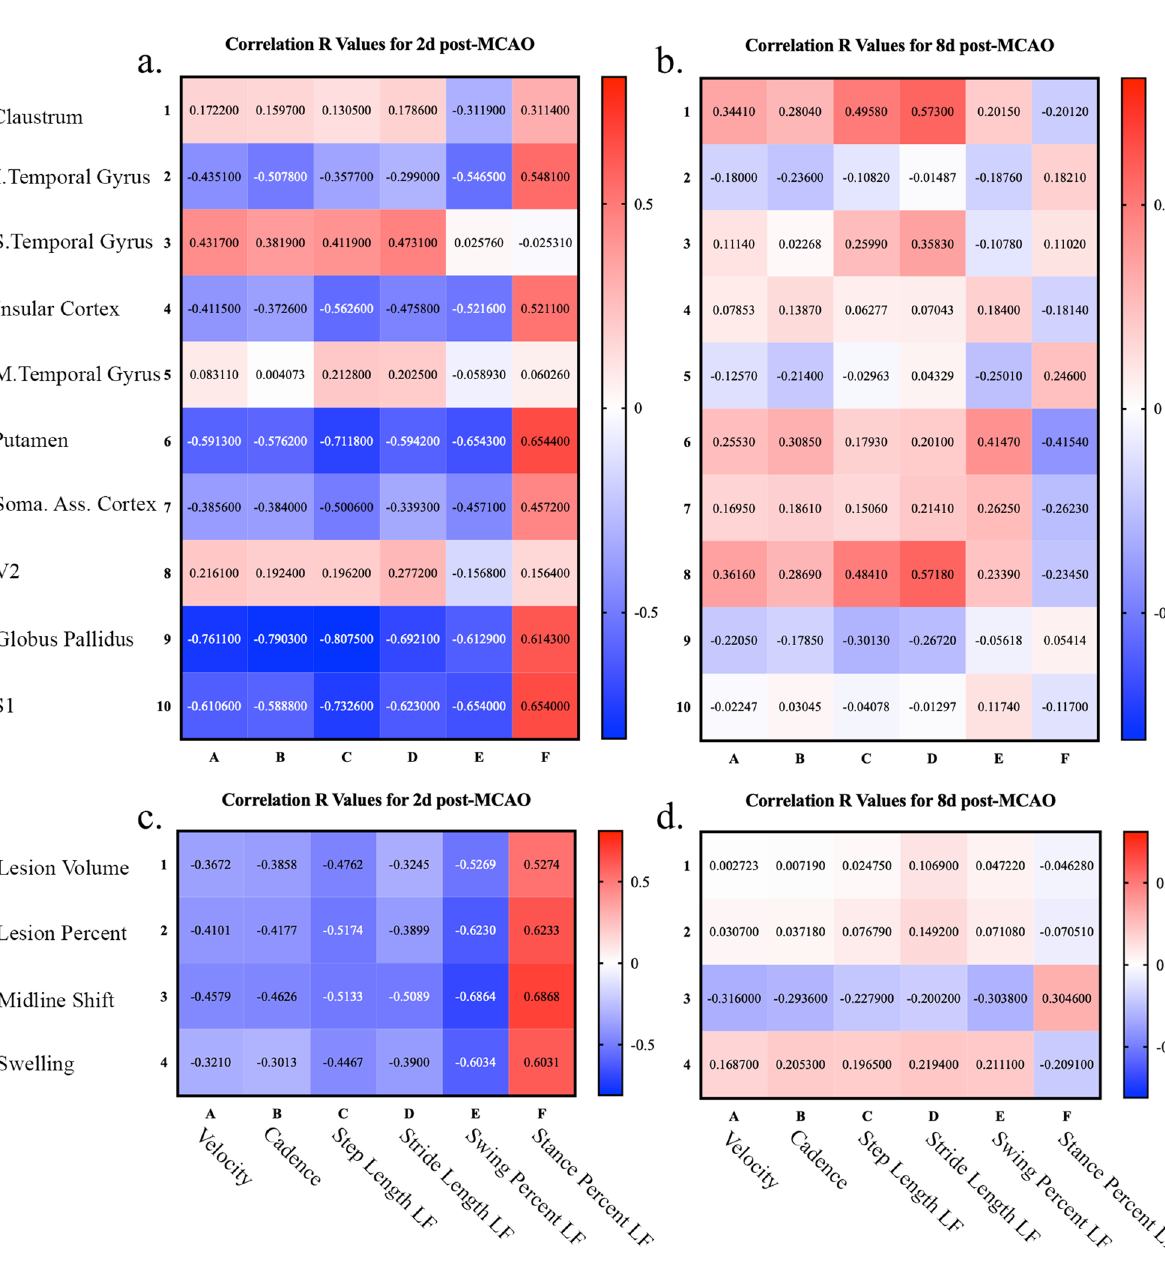
Figure 5. Location of stroke lesion in structures associated with motor coordination had prognostic value when evaluating motor functional outcomes. Pearson correlations between top PoS structures impacted by the lesion (y-axis) to gait functional outcomes (x-axis) were evaluated at 2d post-MCAO ( a ) and 8d post- MCAO ( b ). Pearson correlations between canonical MRI parameters (y-axis), including lesion volume, lesion percent of ipsilateral hemisphere, midline shift, and hemispheric swelling, and gait functional outcomes (x-axis) were evaluated at 2d post-MCAO ( c ) and 8d post-MCAO ( d ). R values were reported with cell color indicating correlation direction and strength. FDR p-values corrected for multiple comparisons can be found in Supplementary Table